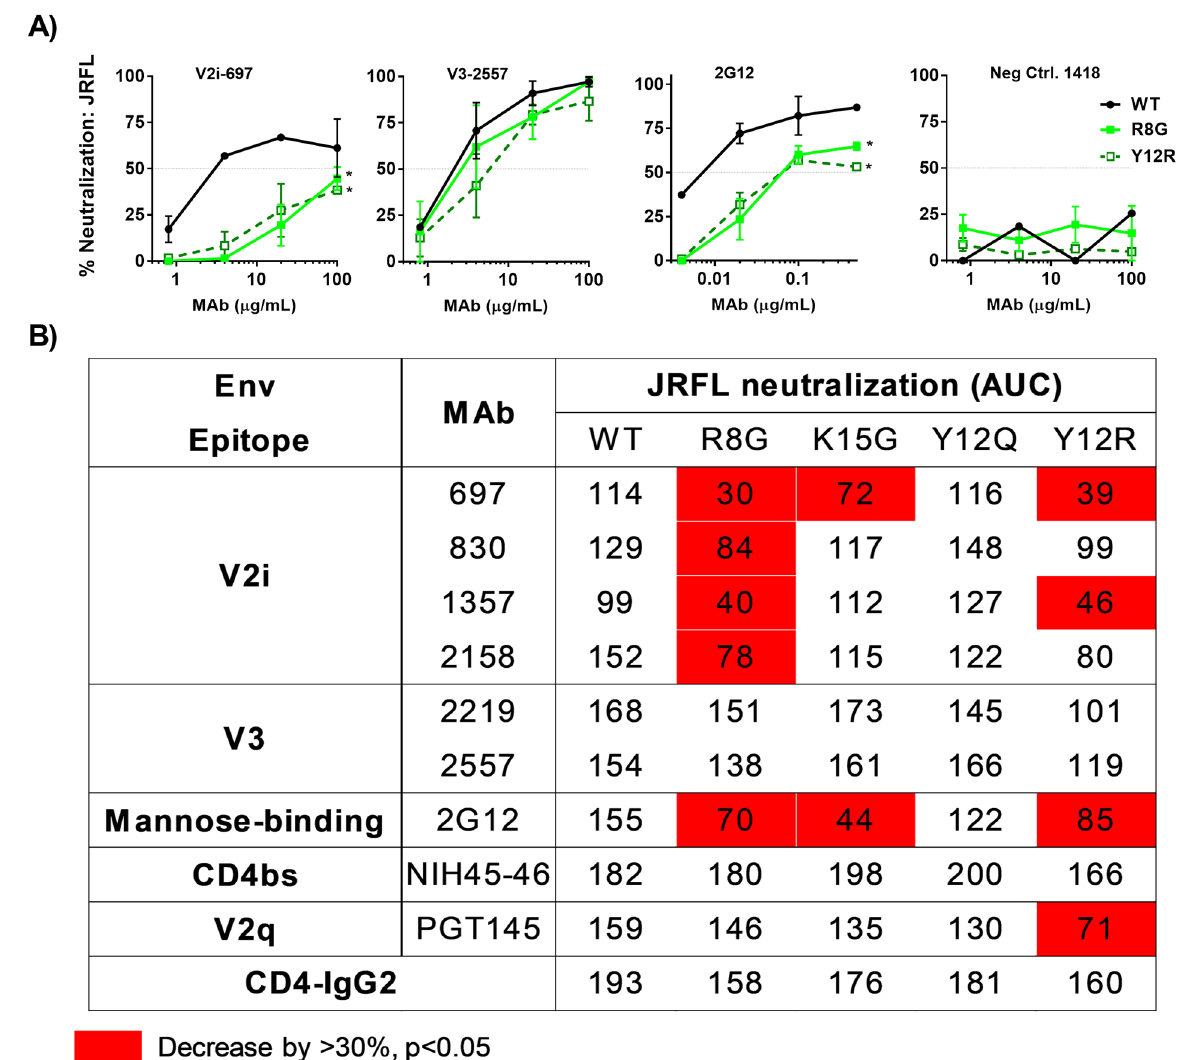
Fig 10. Neutralization of JRFL WT and mutant viruses by different MAbs and CD4-IgG2. Neutralization assays were performed for each of MAb-virus pairs as described in Fig 2. AUC values were calculated from titration curves. A) Titration curves of representative virus-MAb pairs. B) JRFL WT and mutant neutralization by MAbs targeting V2i, V3, V2q, and the CD4bs and by CD-IgG2. AUC values that decreased by > 30% and had p < 0.05 relative to WT are shown in red. Means and standard errors from two to three experiments are shown.